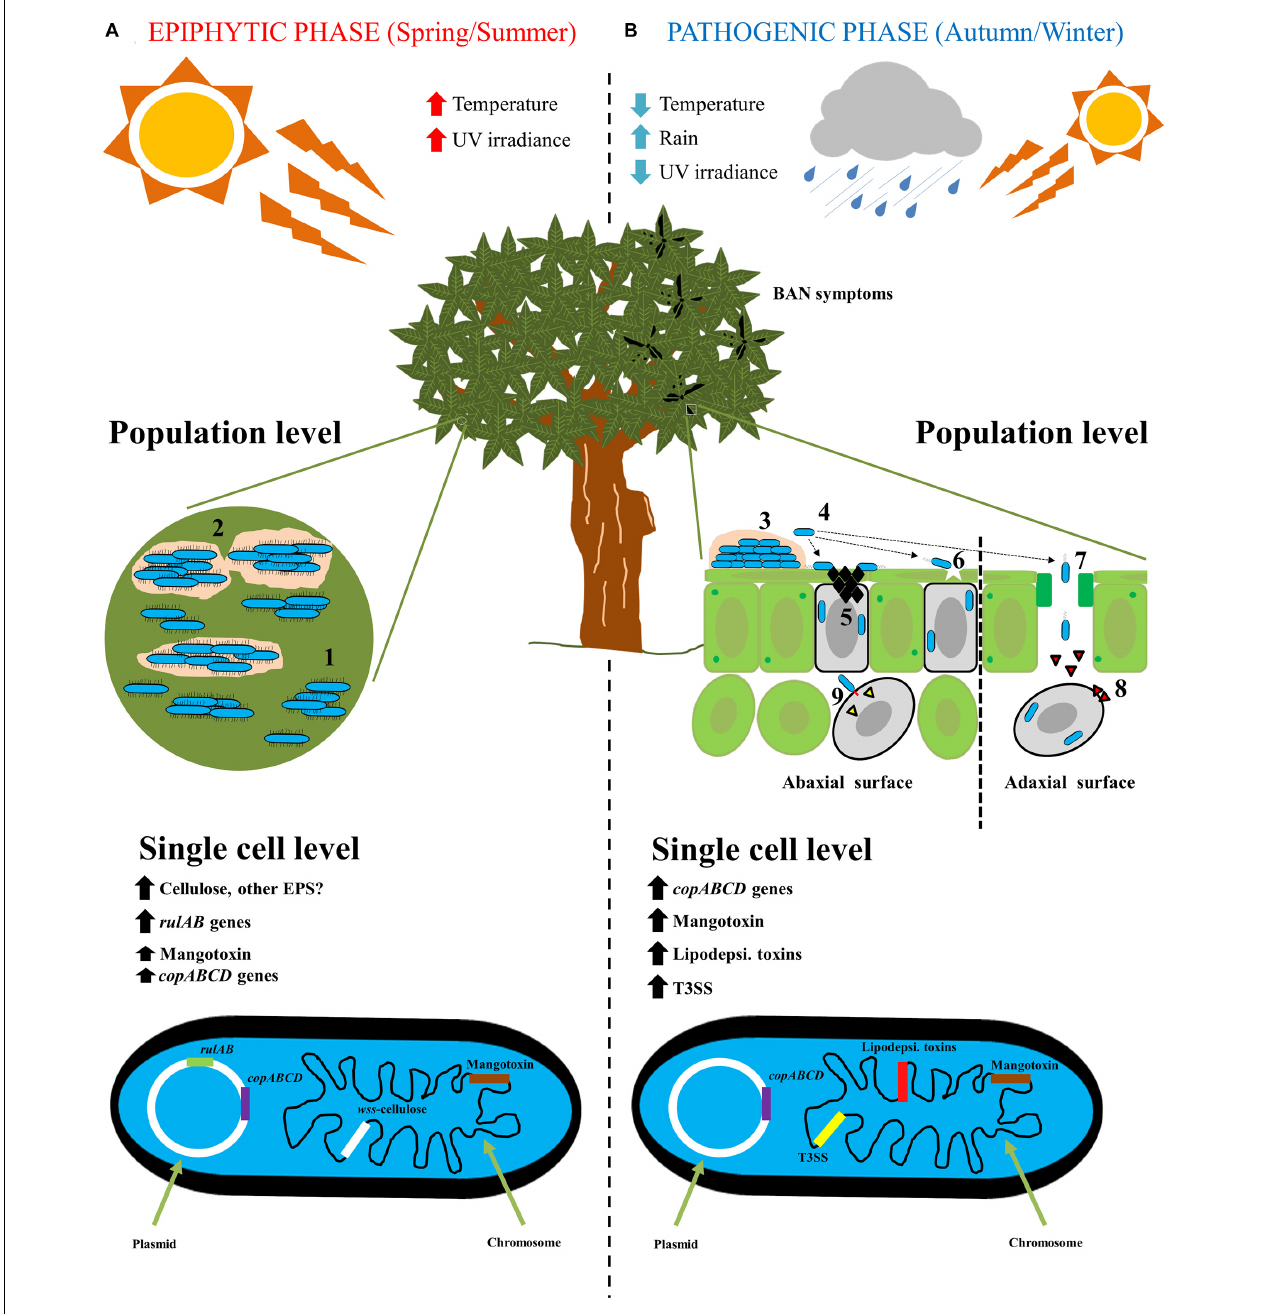
FIGURE 2 | The life cycle of Pseudomonas syringae pv. syringae on mango trees. (A) Epiphytic phase of P. syringae pv. syringae on mango trees is developing mainly in spring/summer seasons, where high temperature and high UV radiation are present. At population level, P. syringae pv. syringae is present mainly on the buds and leaves surfaces forming microcolonies (1), that will subsequently form a mature biofilm with the biosynthesis of an extracellular matrix (2). At single cell level, rulAB operon encoded by 62-kb PFP plasmid involved in resistance to UV radiation, and wss operon present at the chromosome and involved in the biosynthesis of cellulose, are both highly expressed. On the contrary, copABCD operon encoded by 62-kb PFP plasmid involved in copper resistance, and mbo operon located at the chromosome and involved in mangotoxin biosynthesis, are less expressed. (B) Pathogenic phase of P. syringae pv. syringae on mango trees arise primarily in autumn/winter seasons, where low temperatures, low UV radiation and high rainfall are present. At population level, the infection process on mango leaves and buds is the following: (3) epiphytic survival and biofilm formation; (4) biofilm disassembly and bacterial migration; (5) Ice nucleation activity to damage mango surfaces; (6) bacterial entry into cells by microinjuries; (7) Bacterial entry into cells through stomata; (8) Release of phytotoxins; and (9) Release of type III effectors by using the type III secretion system. At single cell level, firstly, copABCD operon involved in detoxification of copper compounds is highly expressed in response to copper treatment applications by farmers. Then, all genes that encode virulence factors are highly expressed (Mangotoxin, lipodepsipeptidic toxins and type III secretion system and its effectors) to elicit the typical BAN disease symptoms.